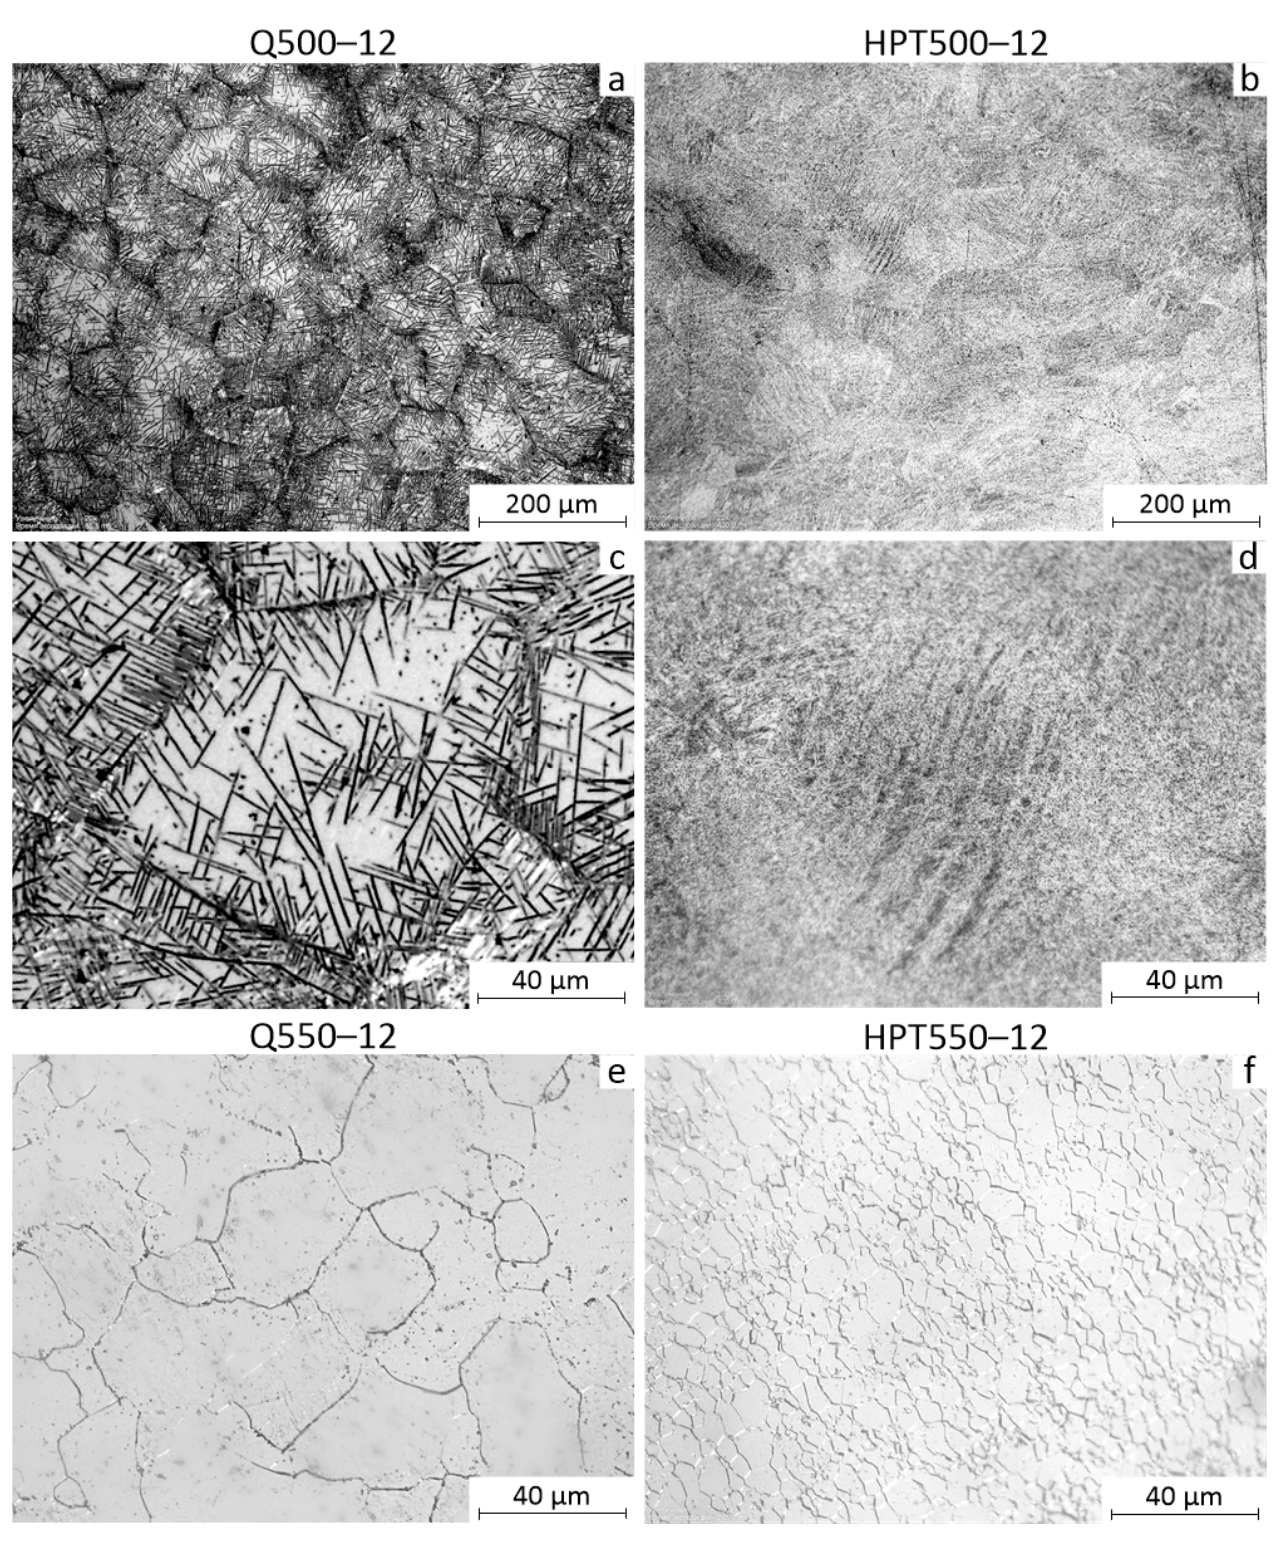
Figure 7. Microstructure of the Ti-18Zr-15Nb alloy after: ( a , c ) Q + 500 °C 12 h; ( b , d ) HPT + 500 °C 12 h; ( e ) Q + 550 °C 12 h; and ( f ) HPT + 550 °C 12 h.